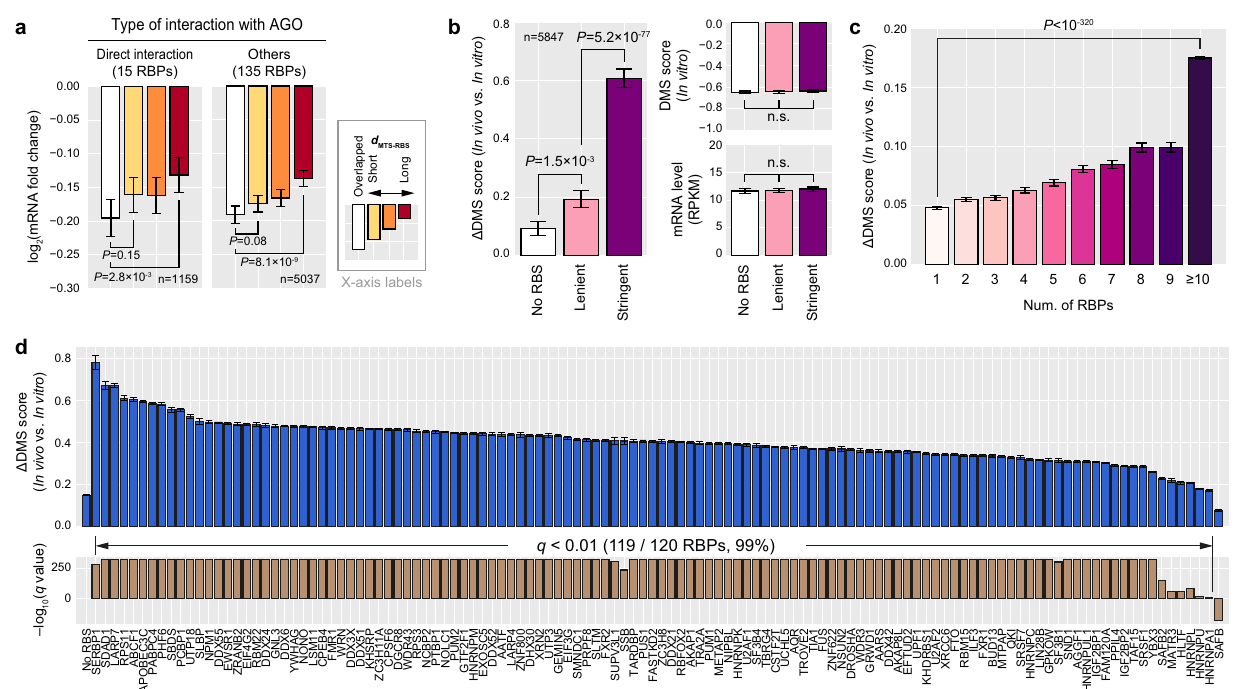
Fig. 4 RBP binding opens up mRNA secondary structures. a Consistent association between miRNA targeting (MT) ef fi cacy and the distance between a miRNA target site (MTS) and the nearest RBP-binding site (RBS) on the 3 ′ UTR, denoted as d MTS-RBS , regardless of the direct interaction between RBP and AGO. 3 ′ UTRs depicted in Fig. 1d were split into four subgroups with respect to the d MTS-RBS for RBPs directly interacting with AGO (left) or d MTS-RBS for the other RBPs (right). Each subgroup was carefully chosen to have statistically indistinguishable confounding features among four subgroups, and mRNA fold changes were compared among these subgroups (see Supplementary Fig. 5b for full versions). Otherwise as in Fig. 1d. b Association between RBSs and mRNA secondary structures. 100 nt fragments of human 3 ′ UTRs were separated into three groups with respect to eCLIP-seq RBSs: ‘ No RBS ’ , ‘ Lenient ’ , and ‘ Stringent ’ include 100 nt fragments with none, leniently called, and stringently called eCLIP-seq RBSs, respectively. Each group was carefully selected to have statistically indistinguishable in vitro DMS scores and expression levels among three groups. For each of the 100 nt 3 ′ UTR fragment, the change of DMS reactivity in vivo ( Δ DMS score), which accurately represents the structural opening of RNA molecules in vivo 40 , were calculated and compared among three groups (left, two-sided Wilcoxon ’ s rank-sum test). Both eCLIP-seq and DMS-seq datasets monitored in K562 were used. The ‘ n ’ indicates the number of 3 ′ UTR fragments. The mean Δ DMS scores are displayed and the error bars represent 95% con fi dence intervals. c Correlation between the number of RBPs and change of DMS reactivity in vivo ( Δ DMS score) for 3 ′ UTR fragments. Δ DMS scores of the fi rst and last bins were compared (two- sided Wilcoxon ’ s rank-sum test). Otherwise as in ( b ). d Change of DMS reactivity in vivo ( Δ DMS score) for individual RBPs. ‘ No RBS ’ group consists of 3 ′ UTR fragments without binding of any RBPs pro fi led in K562 cell line. For each group of fragments which contain speci fi c binding sites of an RBP, Δ DMS scores were compared to that of ‘ No RBS ’ group (two-sided Wilcoxon ’ s rank-sum test), and the statistical signi fi cance after multiple test correction by the false discovery rate is shown below. Otherwise as in ( b